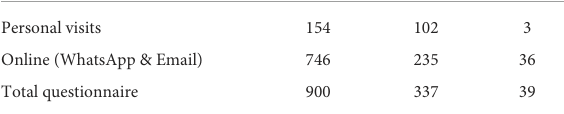
TABLE 1 Questionnaire distributed for data